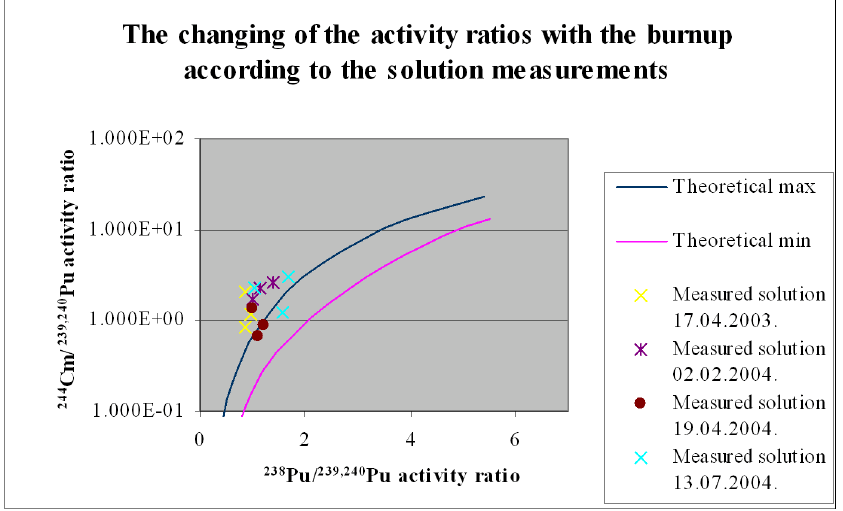
Fig. 9 The measured activity ratios of the actinides in the dissolved fraction (filtrate of the